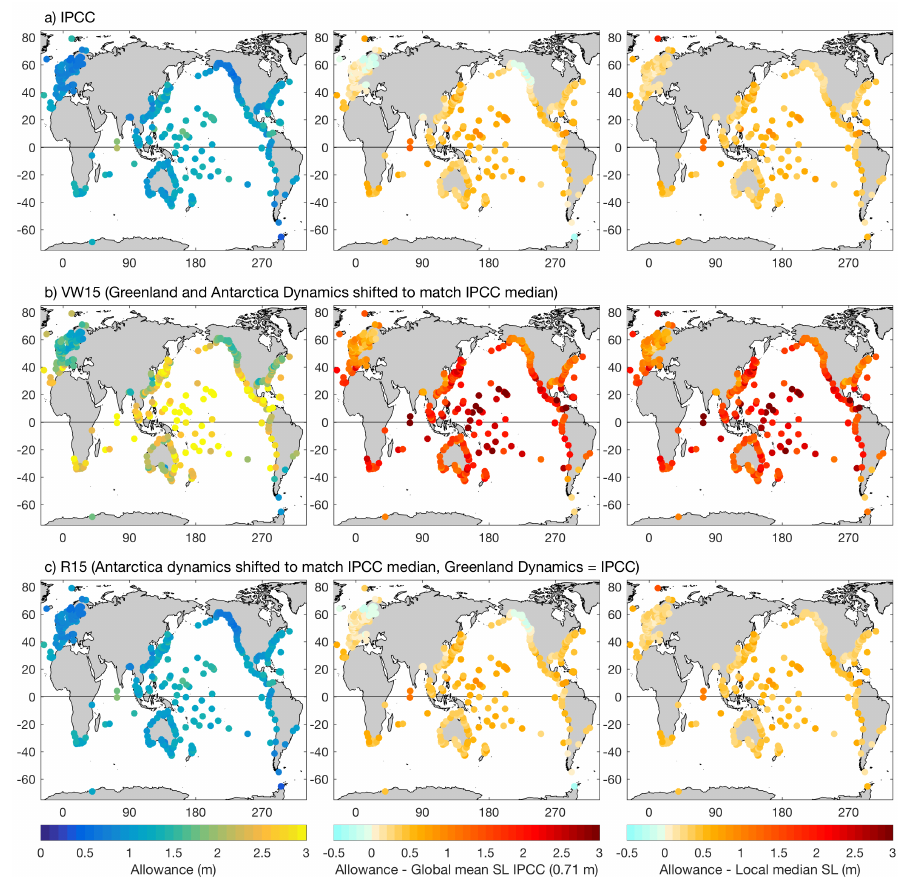
Figure 6. Allowances (m) for 2100 (left column), Allowances minus global mean SLR (middle column, m) and Allowances minus local SLR (right column, m), using 2010–2100 sea-level change projections, all projections have the same median for the projected dynamical ice sheet contributions to SLR but a different shape of the uncertainty distribution. ( a ) IPCC; ( b ) VW15; ( c )